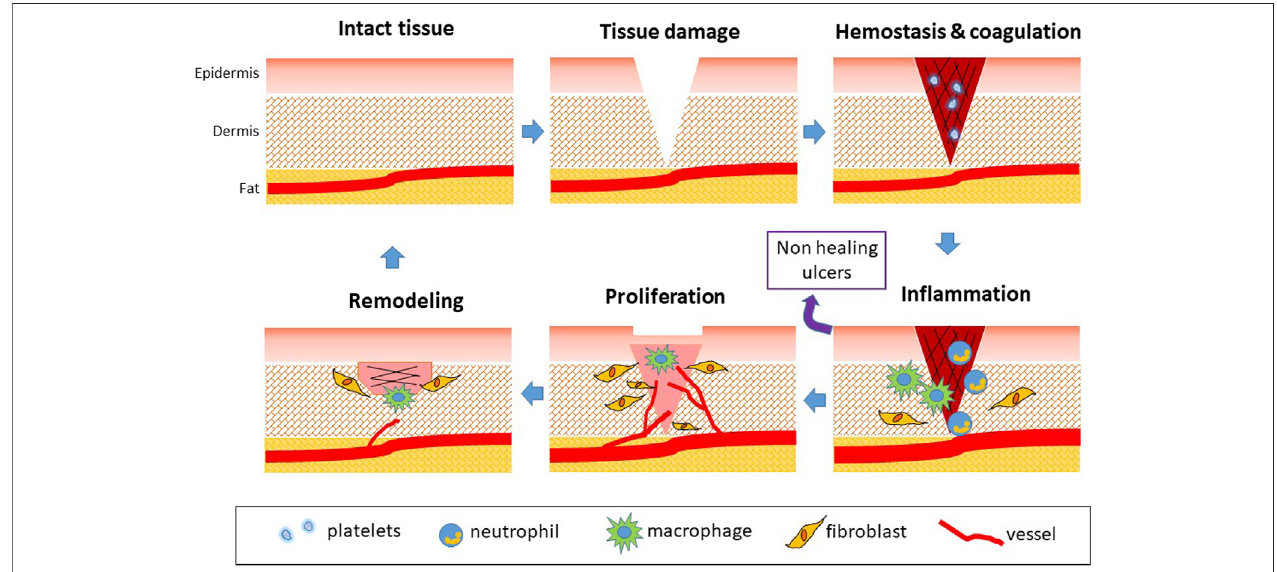
FIGURE1| Phases ofphysiological wound healing. Followingtissue injury, hemostasisoccurs. Coagulation isresponsiblefor fi brinclotting and cessation ofblood fl owing. Platelets activate and secrete PDGF, EGF, TGF- β , CXCL4, and PF4. The following phase is represented by in fl ammation, also induced by tissue debris and bacteria.VesselsdilateinaNO-dependentmanner.Neutrophils(0 – 3 days)exertantimicrobialactivity,secretingMMPsandcytokinesasTNF- α andIL-1/4/6.Monocytes are attracted (1 – 7 days) and transform in M1 macrophages involved in host defense with phagocytic activity. ROS are generated to eliminate bacteria. Then, M2 phenotype occurs with the production of growth factors involved in tissue repair. The proliferation phase is characterized by angiogenesis occurrence due to release of VEGFandFGF,ECproliferationandmigrationand fi broblastproliferation.FibroblastsparticipateinangiogenesisthroughsecretionofproteinasesanddepositionofECM proteins. Reepithelialization starts and actively continues during the remodeling phase, characterized by collagen conversion and vascular regression. The release of TGF- β induces wound contraction and closure, and tissue remodeling, till the recovery of tissue integrity. When in fl ammation persists, wounds do not heal and chronic ulcers